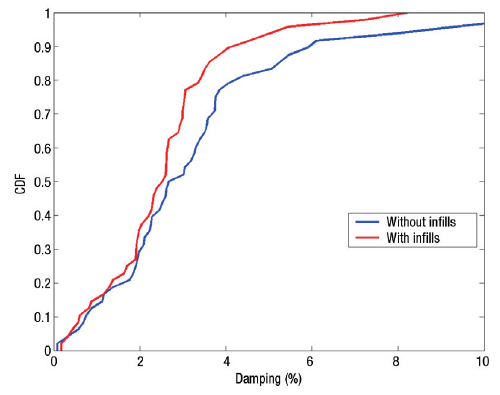
Fig. 8. Comparison of CDFs of damping derived by more than two subsequent maxima for the same building of fig.